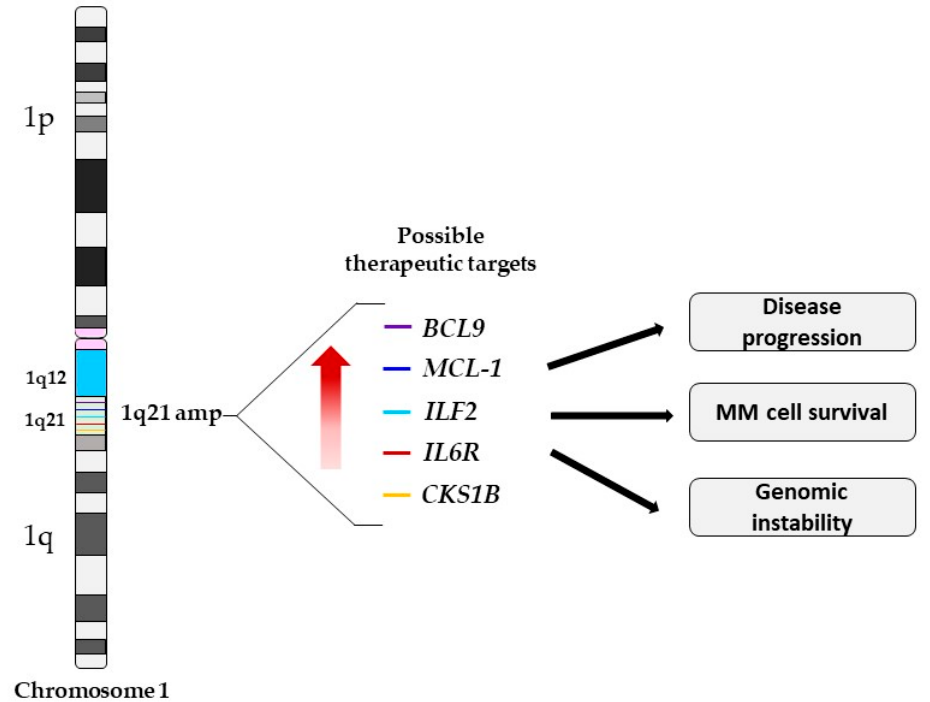
Figure 2. Schematic representation of chromosome 1 indicating the location of the possible genetic driver genes in this region, denoted by colored lines. The amplification of the 1q21 region results in the simultaneous overexpression of several